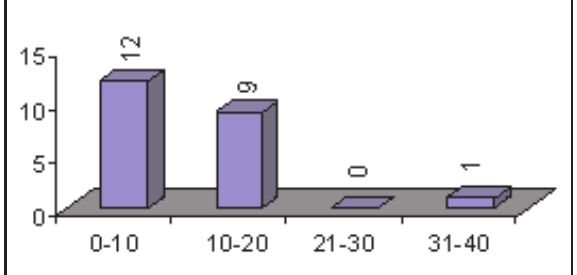
Fig. 3: Burn Surface area in percentage. Majority of patients (96%) have burn injuries less than 20% of total body surface. One patient had burn injury Fig. 1: Injury Site. more than 30 percent of body surface.